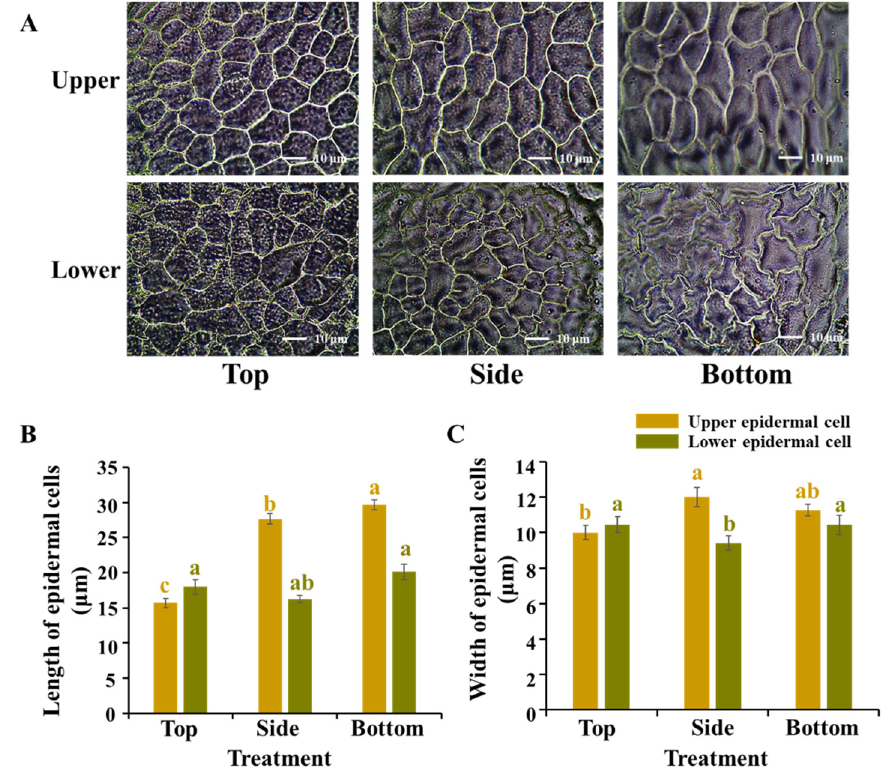
Figure 3. Changes in the upper and lower epidermal cell morphology of strawberry ‘Sulhyang’ plants as affected by the lighting direction after 45 days of cultivation. Upper and lower epidermal cell morphology ( A ), cell length ( B ), and width ( C ) of strawberry leaves. Vertical bars indicate the means ± standard error ( n = 6). Different lowercase letters indicate significant separations within treatments by Duncan’s multiple range test at p ≤ 0.05. Bars indicate 10 μ m.